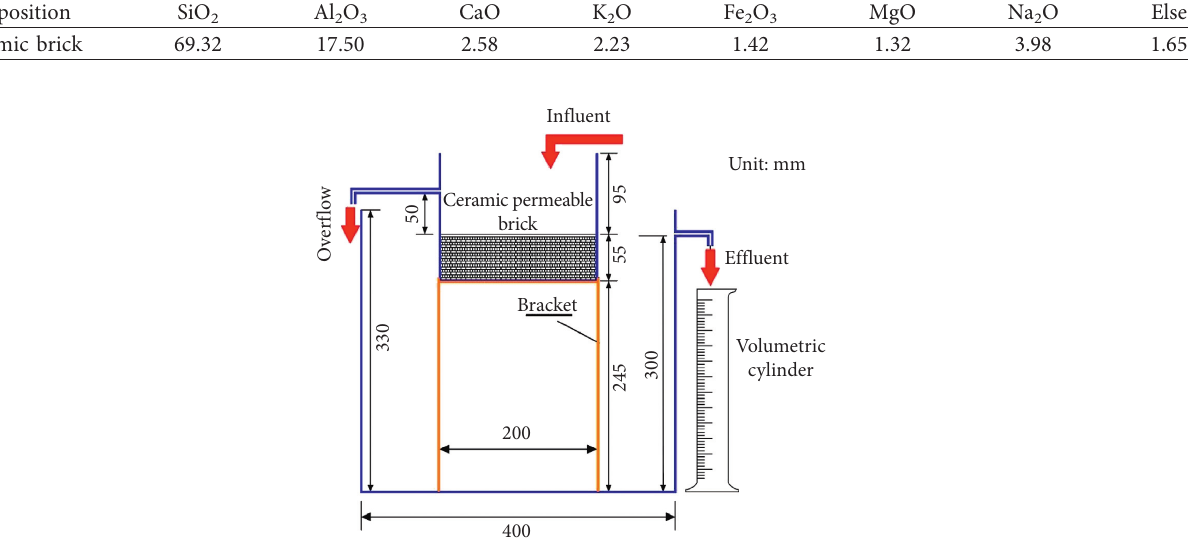
Figure 4: The experimental